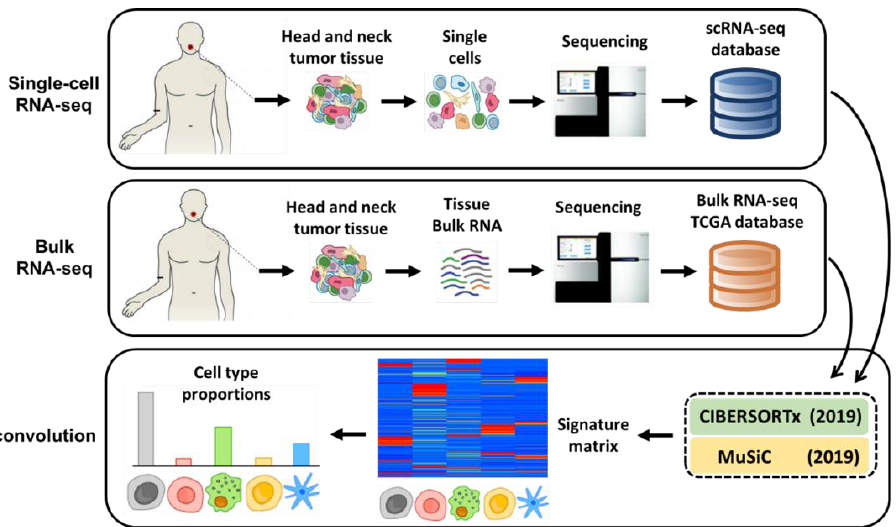
Figure 1. Schematic illustration of the bulk RNA-sequencing (RNA-seq) deconvolution with single-cell reference profile. A schematic overview of deconvolution analysis is illustrated. First, we derived a cell-type expression matrix from our previously profiled transcriptomes of ~6000 single cells by SMART-seq2 protocol from 21 HNSCC (Head and Neck Squamous Cell Carcinomas) samples, including four matched pairs of primary tumors and lymph node metastases. This established a benchmark for cell-type proportions in heterogenous HNSCC tissue. Second, we obtained the bulk RNA-seq data from ~500 HNSCC samples within TCGA. Lastly, we used either CIBERSORTx or MuSiC to derive a signature matrix and then deconvolve the bulk RNA-seq data to get cell